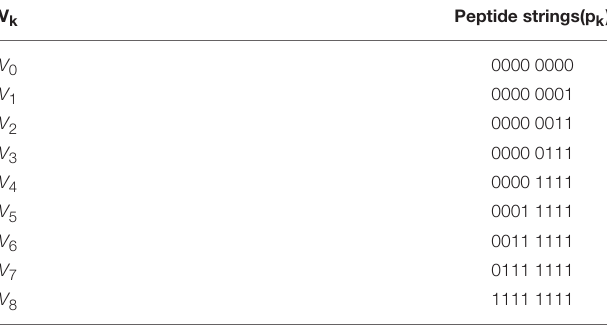
TABLE 1 | Viruses used in the experiments are numbered from zero to eight. V k Peptide strings(p k